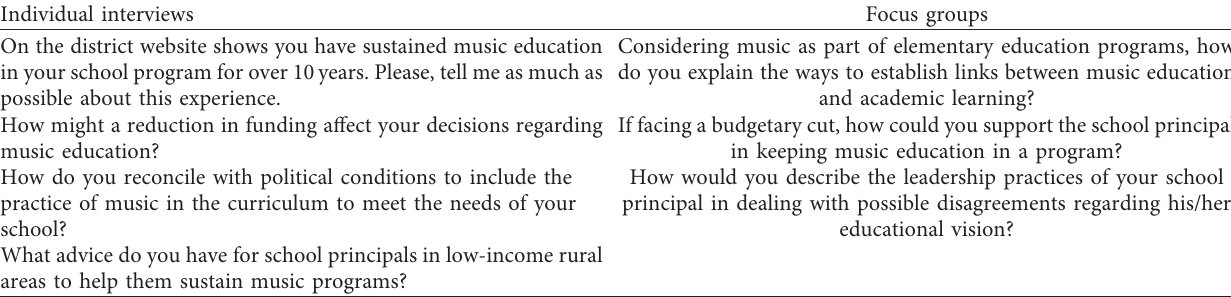
Table 1: Questions for individual interviews and focus